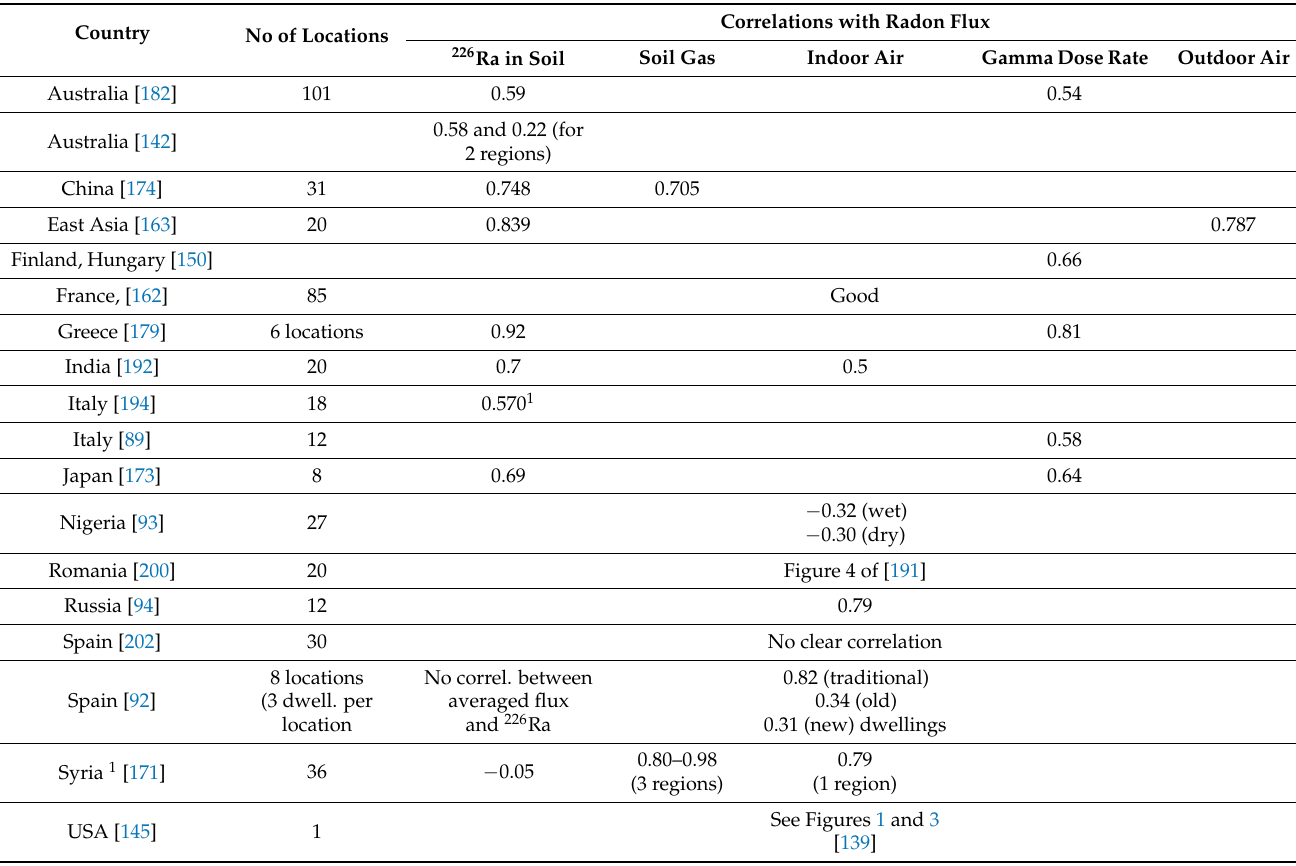
Table 2. Correlation of radon fluxes with other radon